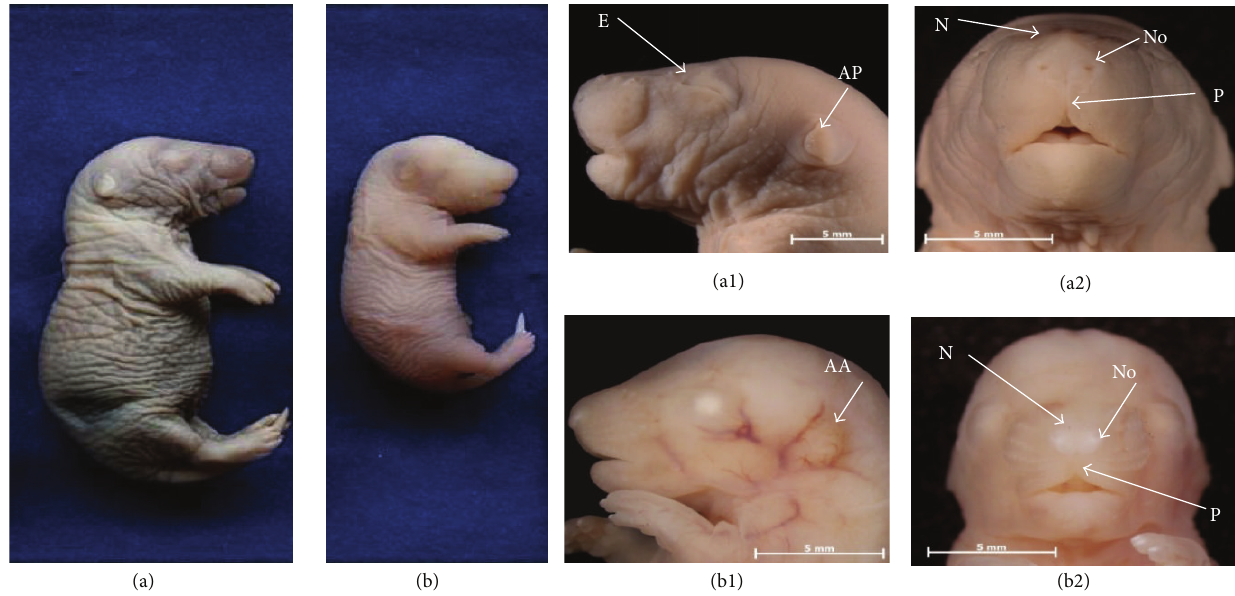
Figure 2: The body and facial morphology of control rat ((a), (a1), and (a2)) and streptozotocin-induced diabetic rat ((b), (b1), and (b2)) fetuses after 21 days of gestation. Note the difference in size of the fetus from the diabetic mother compared with the control and the marked immaturity of the maxillofacial structures. AA = auricular appendage, E = eyelids, AP = auricular pavilion, No = nostrils, N = nose, and P = philtrum.